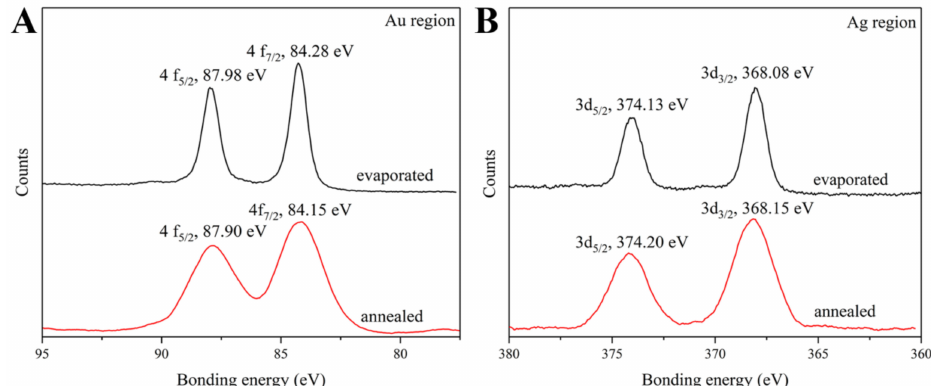
Figure 2. The X-ray photoelectron spectroscopy (XPS) spectra of Au ( A ) and Ag ( B ) regions from both the evaporated (black line) and annealed (red line)